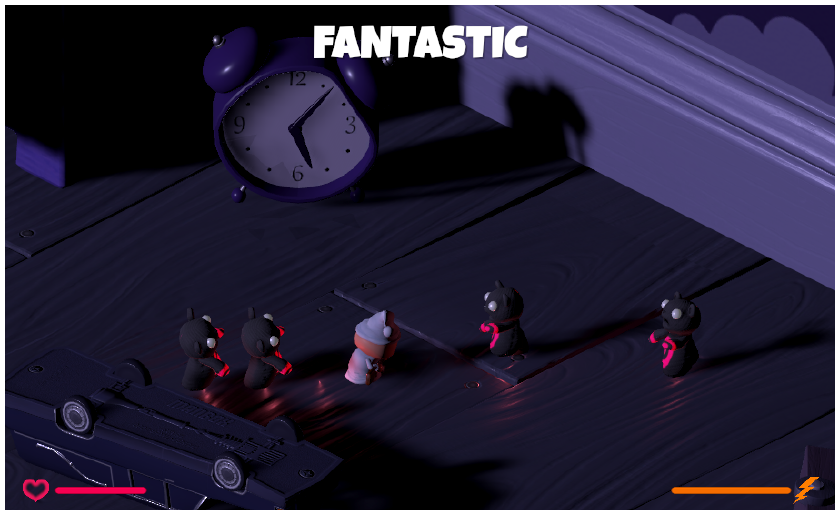
Figure 9. Freud Me Out gameplay screenshot [49].